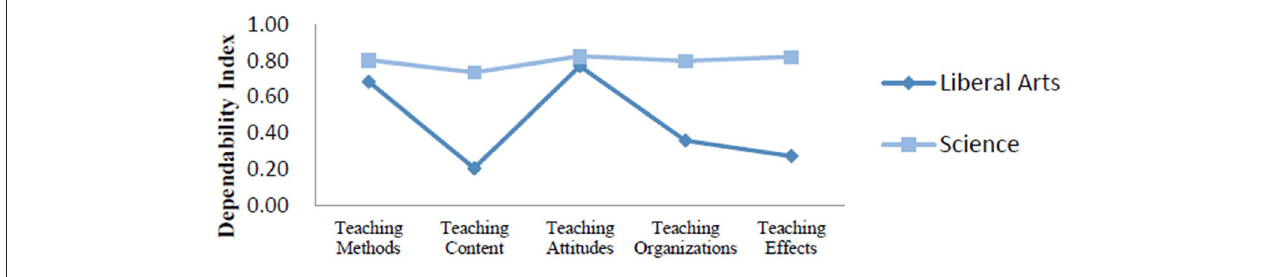
FIGURE 4 | Dependability indexes for different